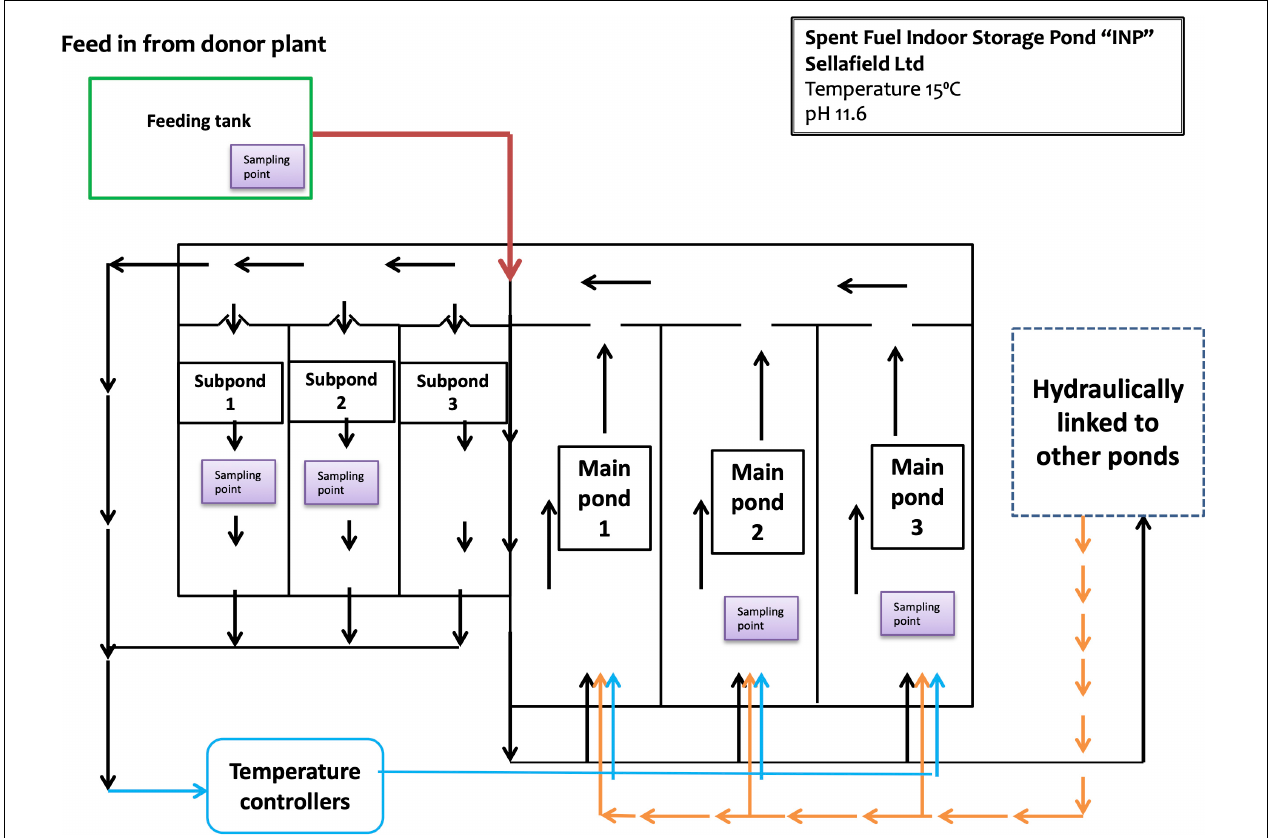
FIGURE 1 | Diagram of the spent fuel indoor storage pond “INP.” It consists of 3 main ponds and 3 subponds linked by a transfer channel which enables water flow. The sampling points are located at the main ponds 2 and 3; subponds 1 and 2; and the head feeding tank (at the top of the pond).